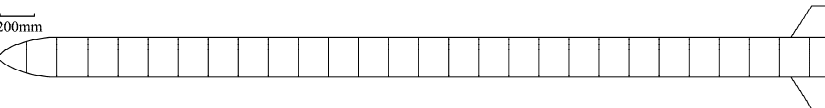
Figure 12. Aerodynamic segment division of the slender vehicle.